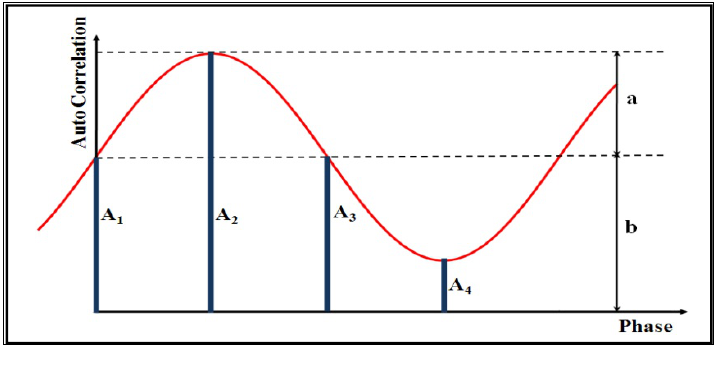
Figure 1. Autocorrelation function, phase shift, amplitude and